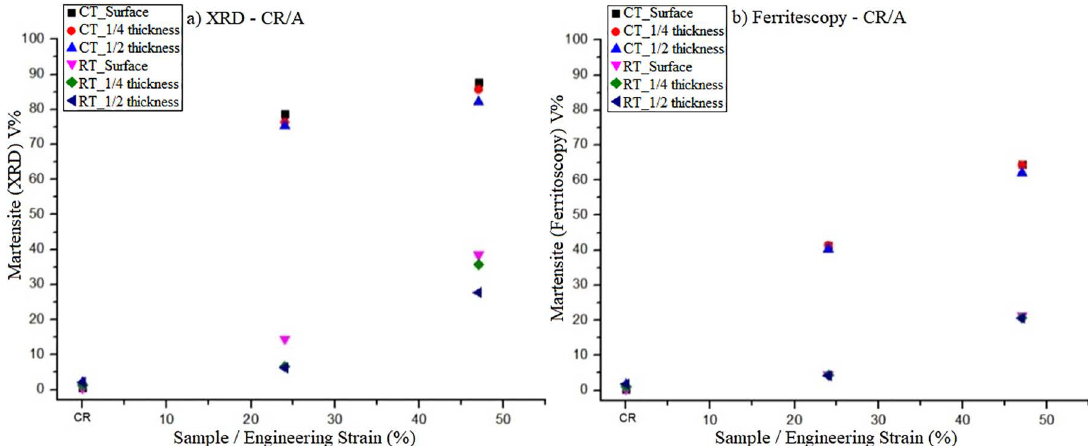
Figure 4. Induced martensitic transformation by tensile test at 298 K (RT) and 155 K (CT) in CR/A samples.